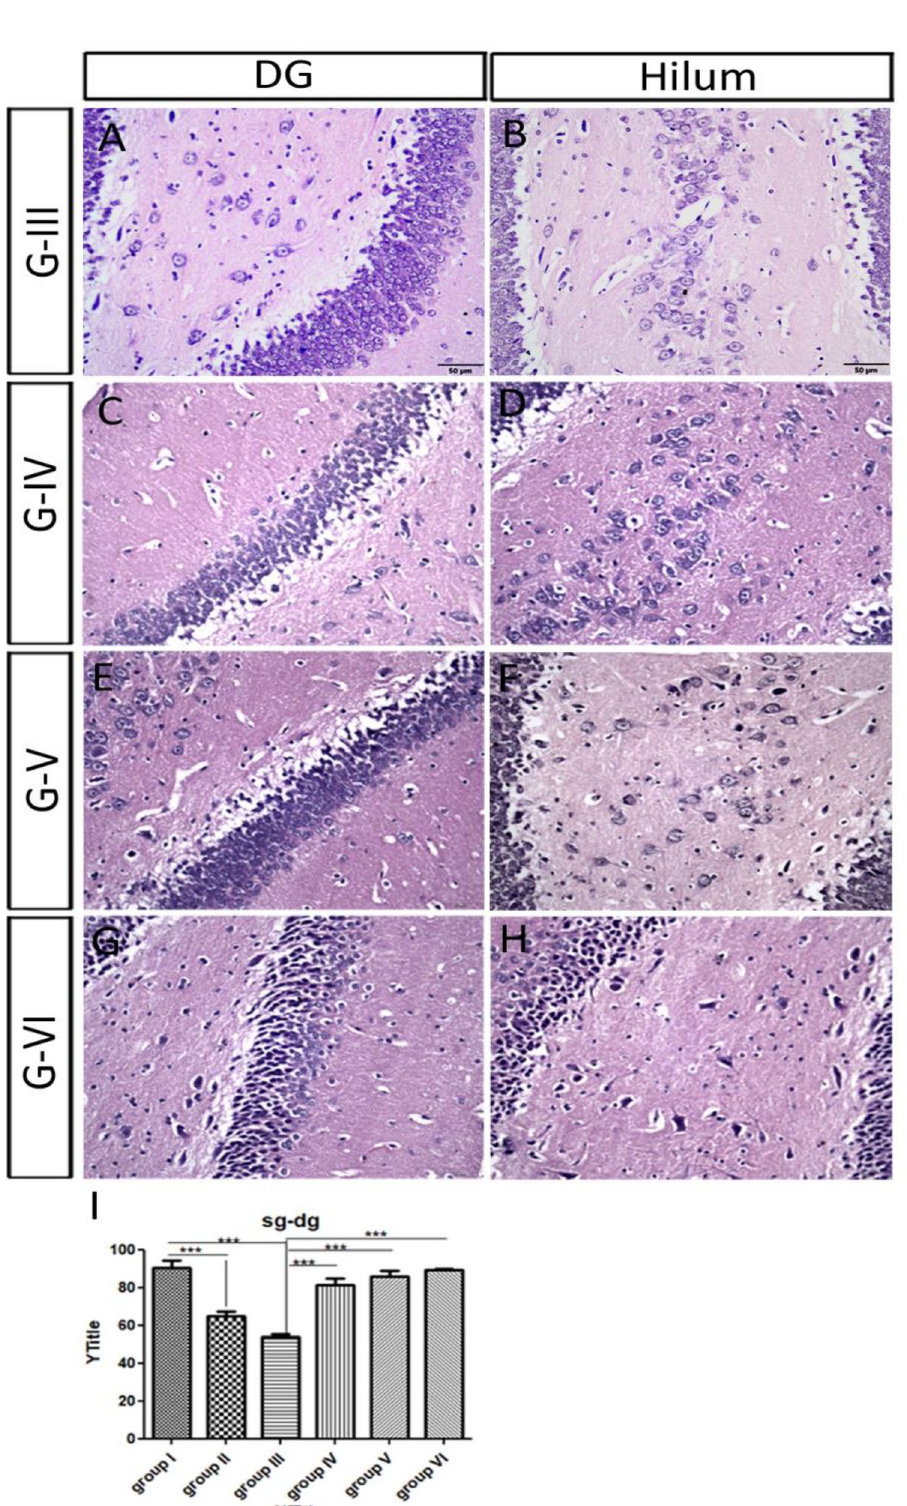
Figure 6. Showing the dentate gyrus of low and high dose ivabradine and donepezil treated groups. ( A , B ) The cells degenerated in the granular layer and in the hilum of the ES group III. ( C , D ) Group IV, low ivabradine dose. ( E , F ) Group V, high ivabradine dose, ( G , H ) group VI, donepezil. In the later three groups, the mean number of the cells per section in the hilum increased. The inner layers of the granular layer were dense and small. ( M – O ) Quantification of the thickness of granular layer of the dentate gyrus in all groups of the experiment including the control (I), the scopolamine (II), the ES (III), the low ivabradine (IV) and high dose (V) of ivabradine and donepezil (VI) on of ES administrative